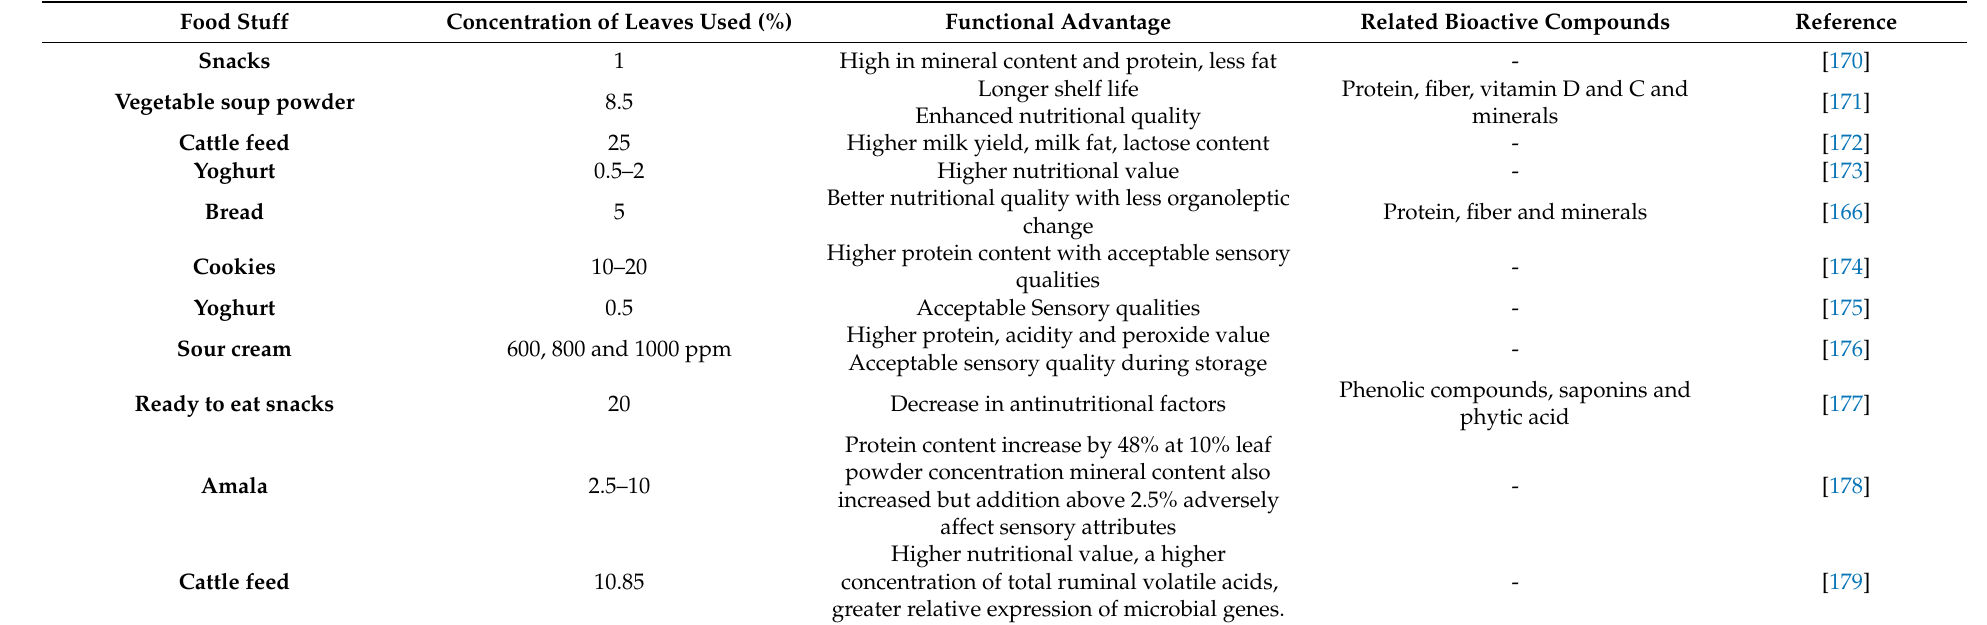
Table 4. Applications of Moringa oleifera leaves as a functional ingredient in food